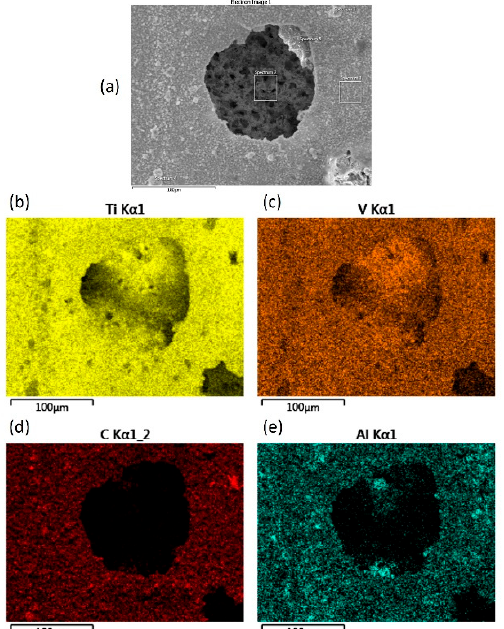
Figure 14. EDS element distribution map of corrosion pit formed on the surface of carburized sample: ( a ) secondary electron image of studied area, ( b ) titanium distribution map in tested area ( c ) vanadium distribution map in tested area, ( d ) carbon distribution map in tested area ( e ) aluminum distribution map in tested area.